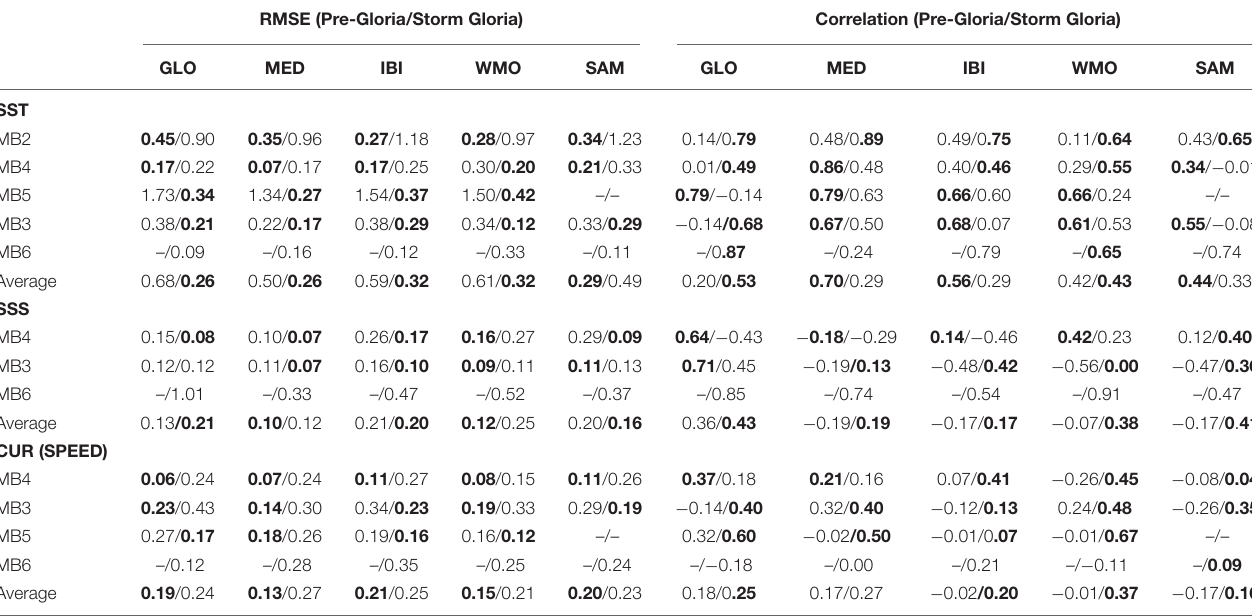
TABLE 2 | Model validation metrics (RMSE and correlation values) computed for the five different models when compared with observations of Sea Surface Temperature (SST), Salinity (SSS), and Current speed (CUR) at the different mooring buoys available during storm Gloria. RMSE (Pre-Gloria/Storm Gloria) Correlation (Pre-Gloria/Storm